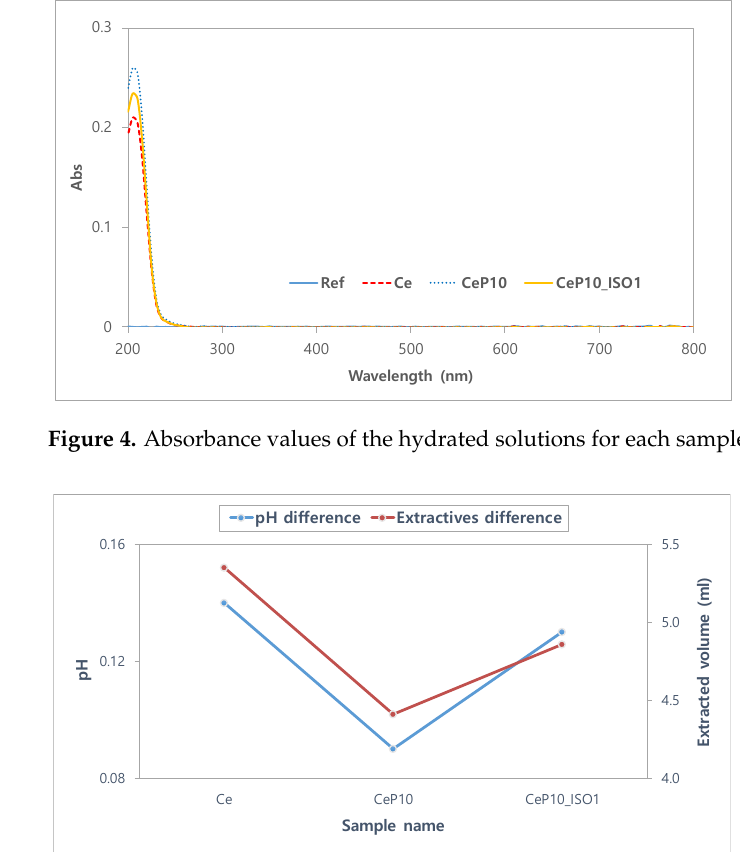
Figure 5. pH and extractables test of samples.